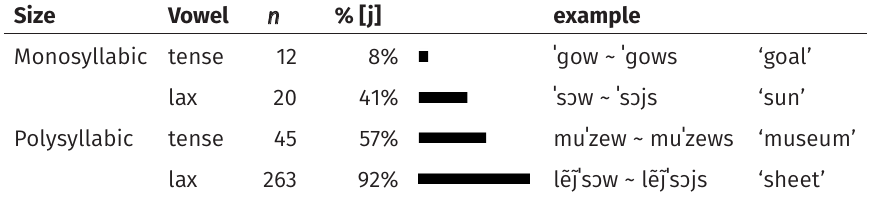
Table 1: Lexicon study: the plural [w ~ j] alternation is more frequent in polysyllables and following a lax